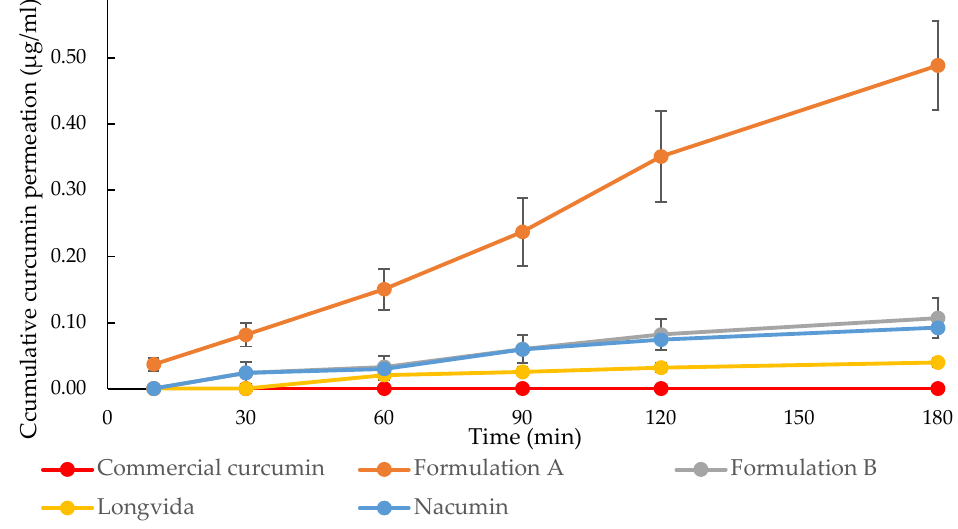
Figure 12. Cumulative amounts of curcumin passing through the Caco-2 cell monolayers, from the apical to the basolateral chambers, A-B ( n = 9, mean ± SD).